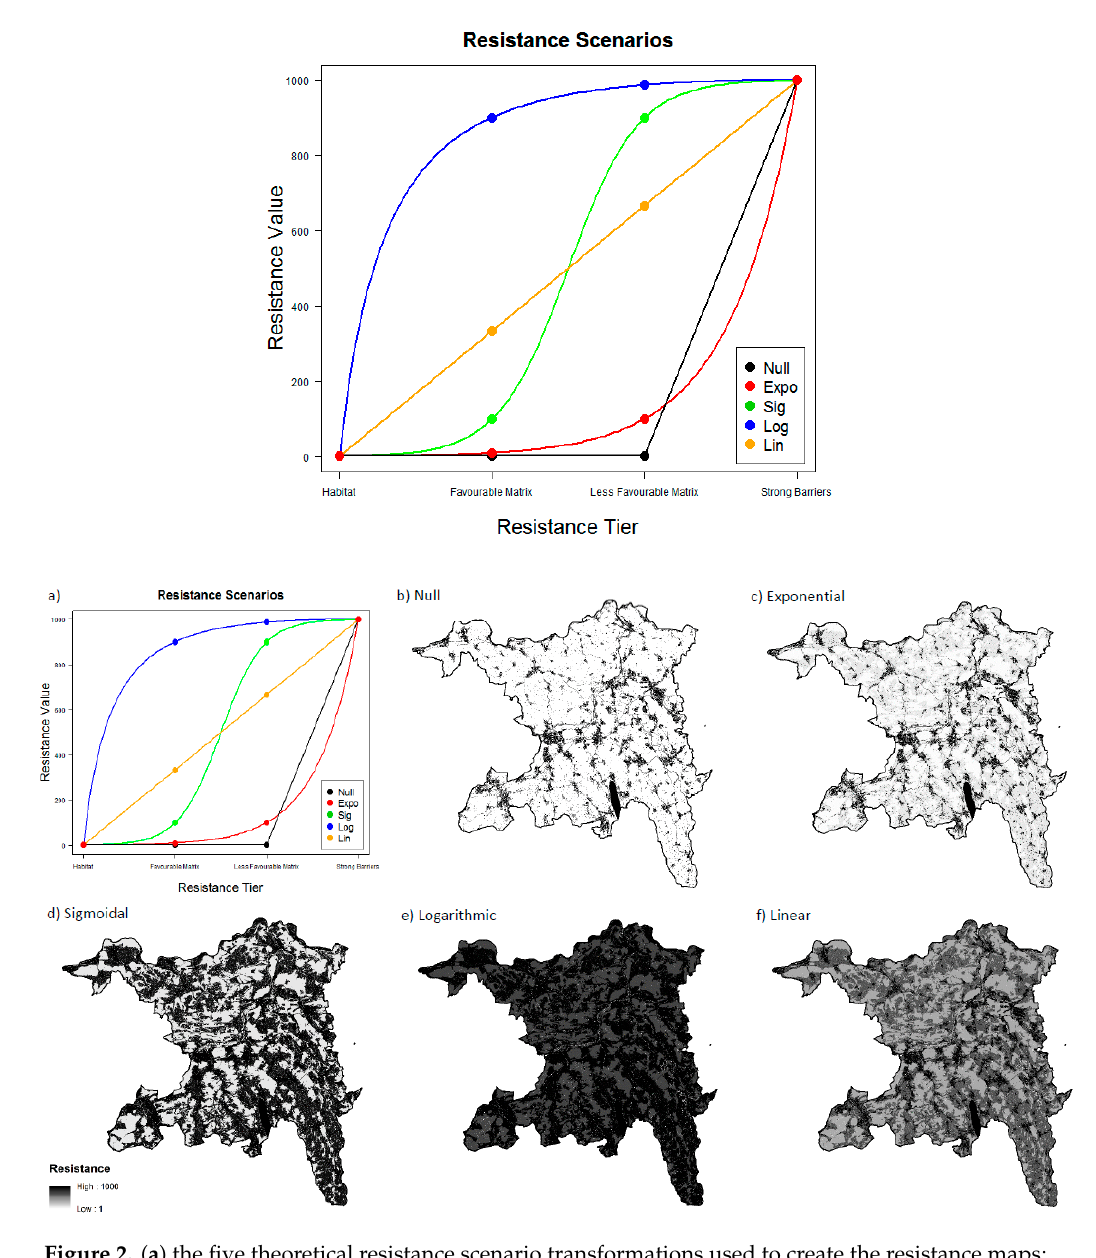
Figure 2. ( a ) the five theoretical resistance scenario transformations used to create the resistance maps; ( b – f ) show examples of the five resistance maps used in Circuitscape analyses for each species (seen here for A. obstetricans) . Cells are shaded from white to black with increasing resistance. Each resistance map is derived by assigning one of the five resistance. scenarios from panel ( a ) to the habitat resistance rankings for each species in Table 1.